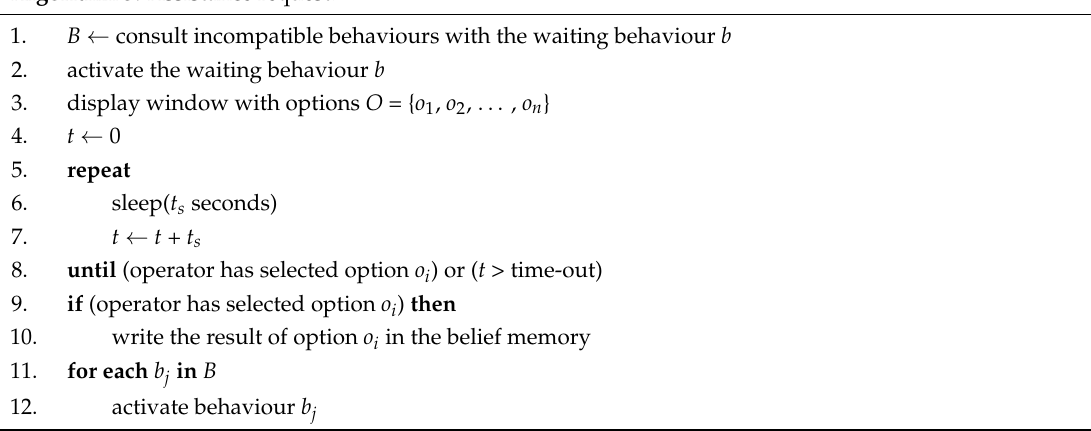
Algorithm 3. Assistance request.